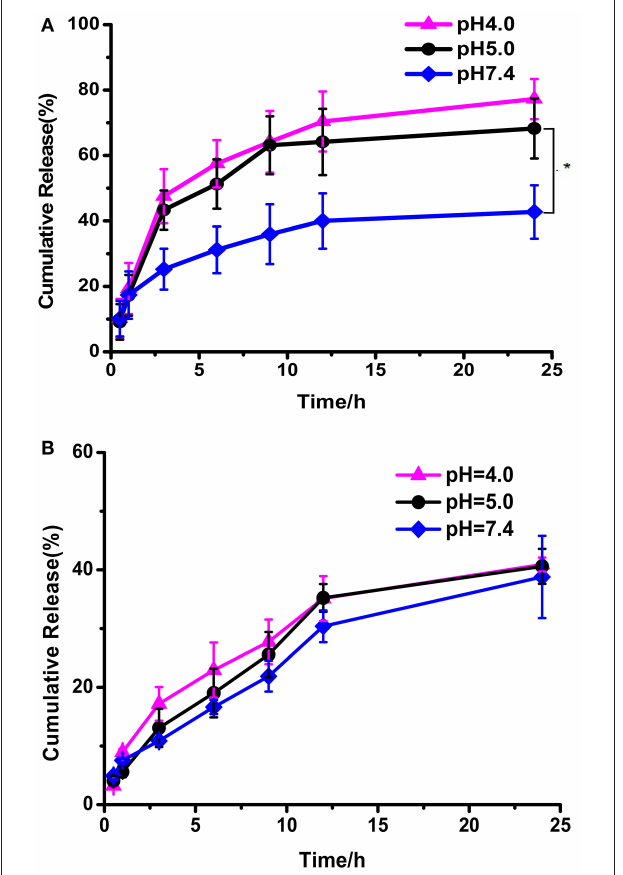
FIGURE 6 | In vitro release of DOX from PEG-DiHZ-PLA-18K (A) ; PLA-PEG-PLA-18K (B) micelles. Error bars indicate the standard error of the mean (SEM) for n = 3 independent experiments (* p < 0.05).